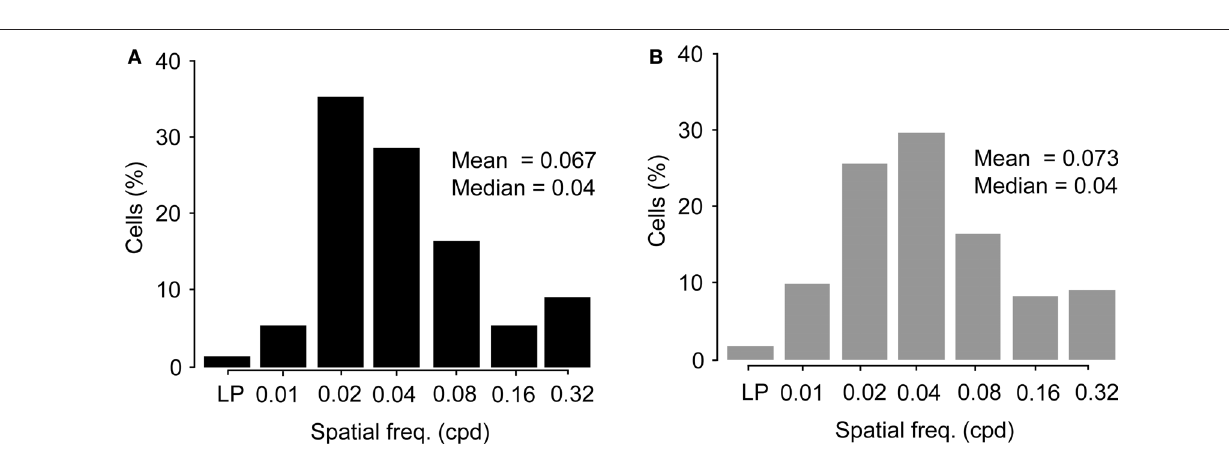
FiGure 7 | Comparison of preferred spatial frequencies. (A) Distribution of spatial frequency tunings of Wfs1 ( + ) cells ( n = 191) across the six tested octaves. LP, low pass tuned cells. (B) Distribution of spatial frequency tunings of unidentified cells ( n = 249) across the six tested octaves. LP, low pass tuned